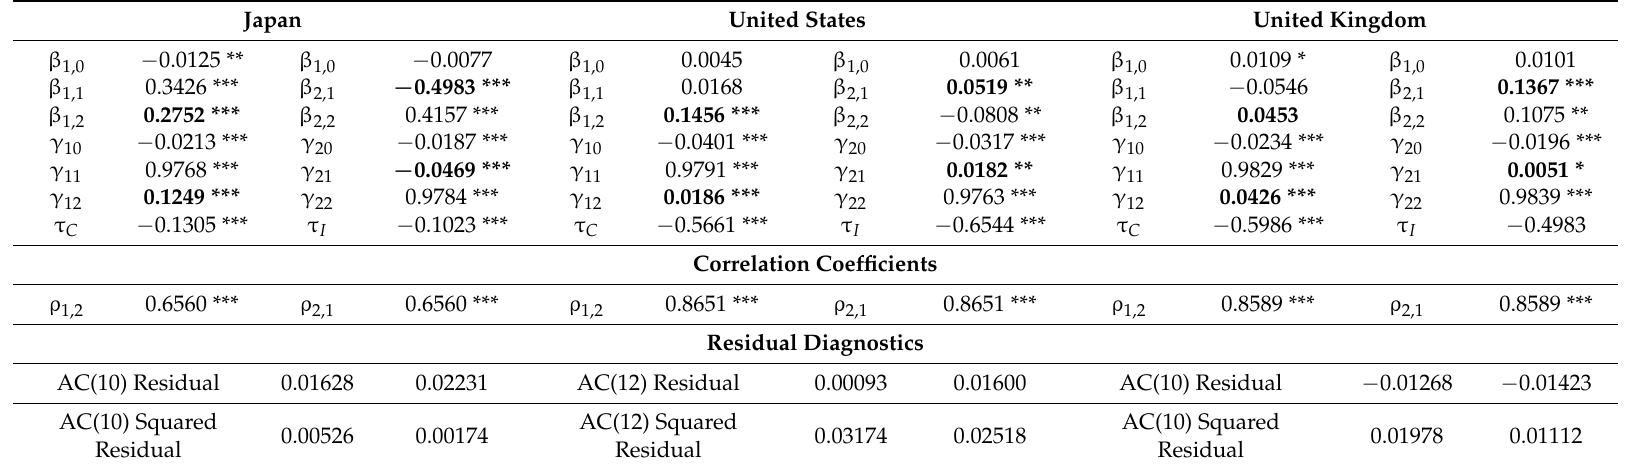
Table 2. Estimation from the bivariate VAR-EGARCH (full